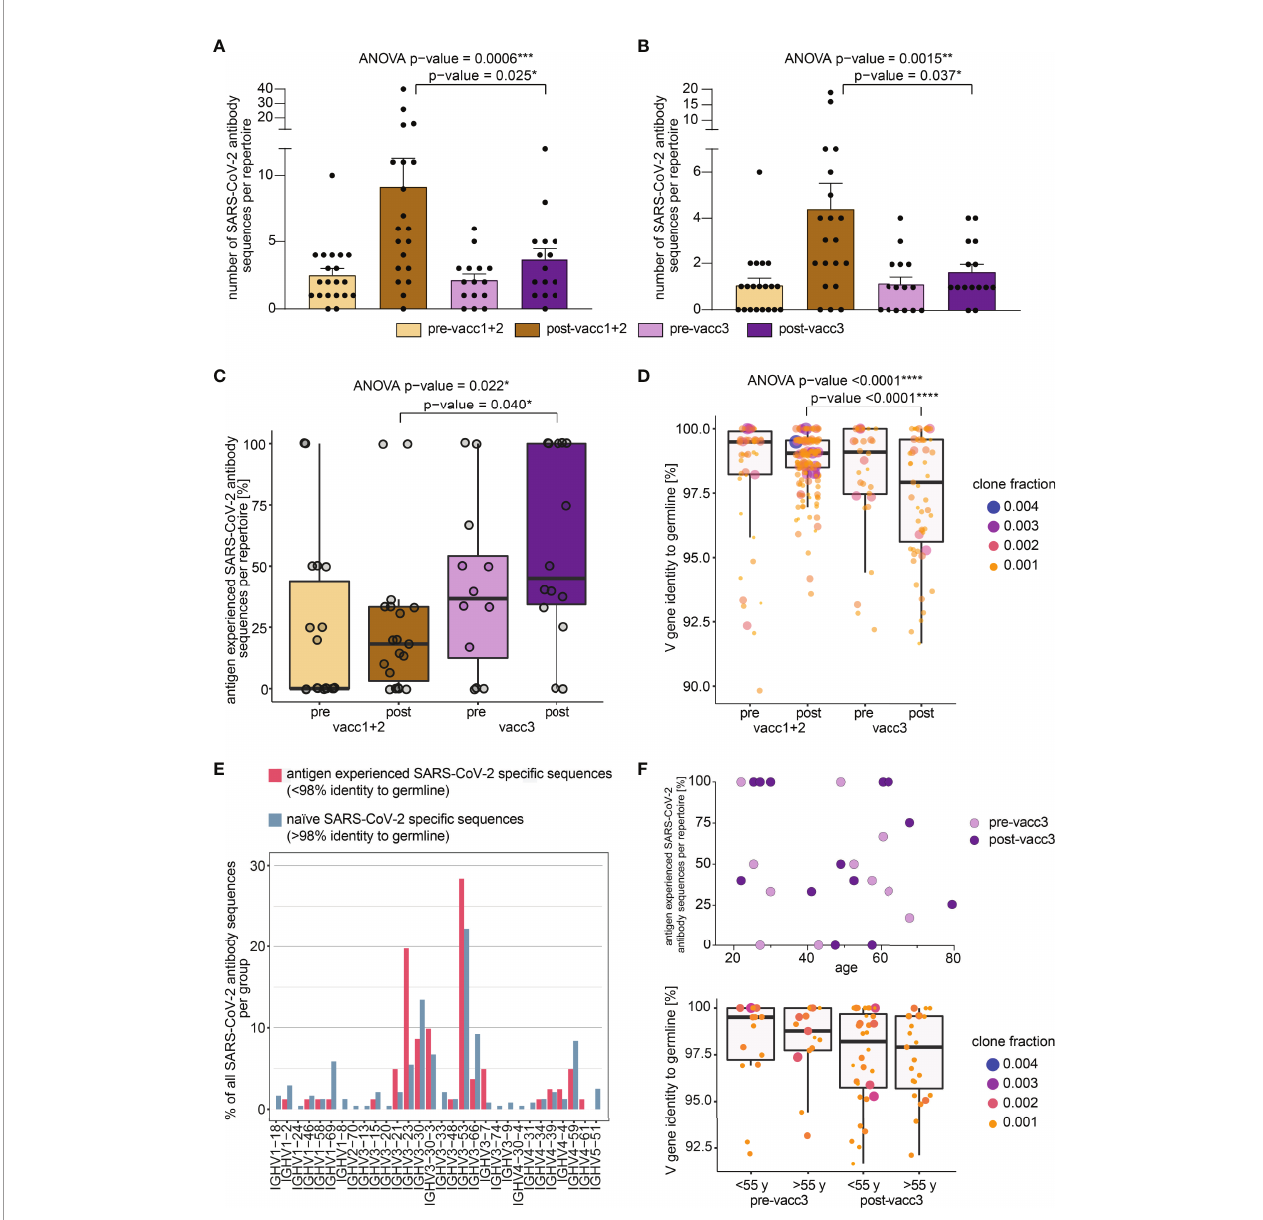
FIGURE 4 | Search of SARS-CoV-2 directed B cell clonotypes in matched pre- and post-vaccination blood samples. Search of 3,195 total (A) and 1,147 neutralizing (B) antibody sequences in all immune repertoires. Bars indicate mean ± s.e.m. (C) Somatic hypermutation analysis of SARS-CoV-2 directed antibody sequences. The percentage of antigen experienced clones within the SARS-CoV-2 speci fi c subrepertoires per patient is shown. A clone was considered antigen- experienced if the IGHV gene showed < 98% identity to the germline nucleotide sequence. (D) Somatic hypermutation load per SARS-CoV-2 directed antibody sequence is shown. Respective clone fractions are coded by color/size. Box and whiskers plot are shown in the style of Tukey. Ordinary one-way ANOVA was performed as statistical test and post-ANOVA analyses between individual columns were performed using Tukey ’ s multiple comparisons test. p-value cut-offs: <0.05 signi fi cant (*), <0.01 very signi fi cant (**), <0.001 extremely signi fi cant (***), <0.0001 extremely signi fi cant (****). (E) IGHV gene usage in naïve versus antigen- experienced SARS-CoV-2 directed antibody sequences. (F) Somatic hypermutation analysis of SARS-CoV-2 directed antibody sequences before and after the third vaccination (pre-/post-vacc3) in correlation to participant ’ s age. The percentage of antigen experienced clones within the SARS-CoV-2 speci fi c subrepertoires per patient is shown in the upper panel. Somatic hypermutation load per SARS-CoV-2 directed antibody sequence is shown before and after the third vaccination (pre-/ post-vacc3) subdivided into age groups of </> 55 years (y) in the lower panel. Respective clone fractions are coded by color/size. Box and whiskers plot are shown in the style of